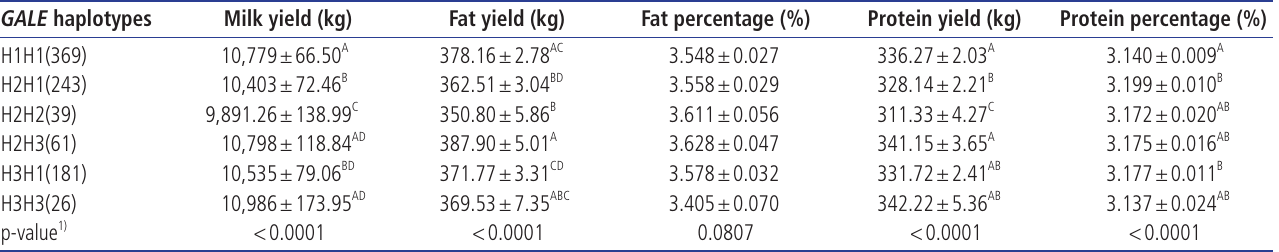
Table 6. Haplotype associations of GALE single nucleotide polymorphisms with milk production traits in Chinese Holstein cattle (LSM±SE) GALE